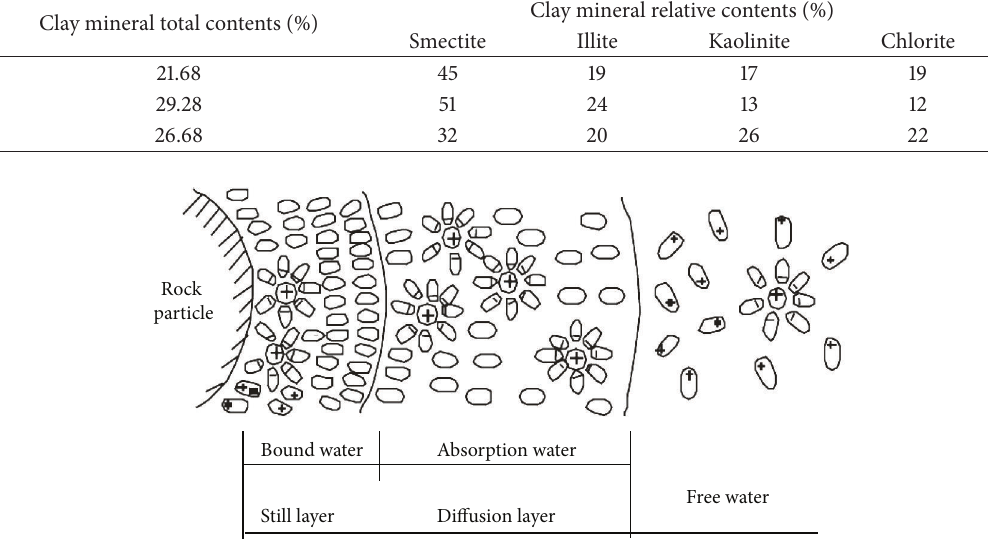
Figure 3: Water existing states in shale